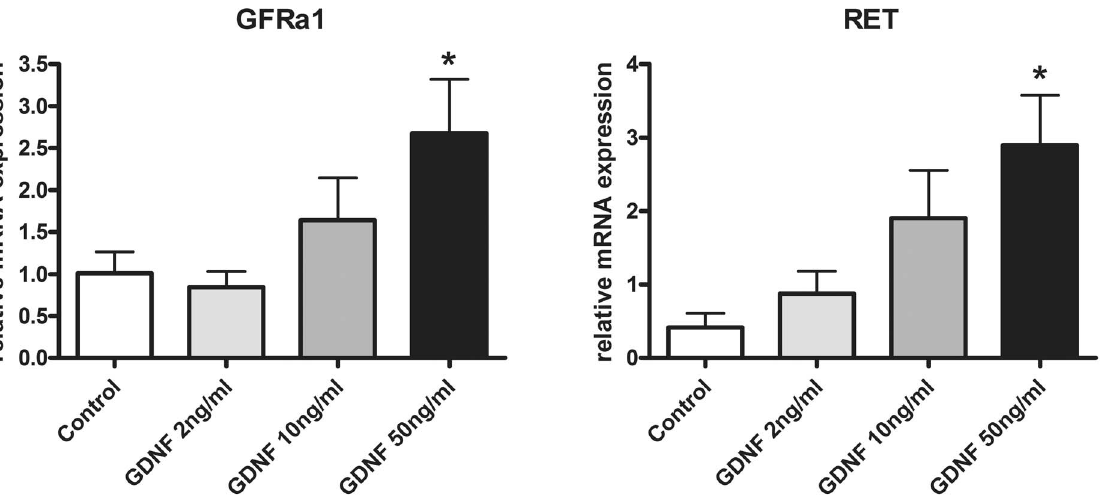
Figure 3. mRNA expression of GDNF receptors in enteric nerve cell cultures following GDNF treatment. Treatment with GDNF for 1 week increases mRNA expression of GDNF receptors GFR a 1 (A) and RET (B) in enteric nerve cell cultures. mRNA expression levels are normalized to mRNA expression of the house-keeping gene HPRT. Data are shown as mean + / 2 SEM, n=14–15 per experimental group, *p , 0.05 vs. control.